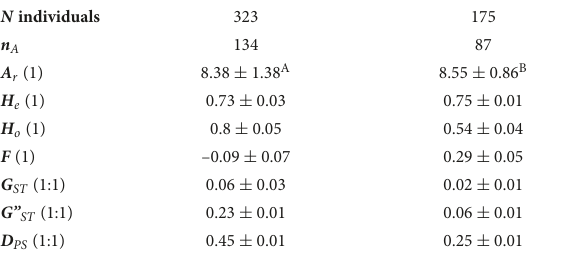
( Supplementary Table 11.2 ). In the MLPE models, geographic distance had a significant effect on G” ST but not on D PS of M. scalare ( Figure 3 and Supplementary Table 11.1 ). With every kilometer, the G” ST of M. scalare increased by 12%.